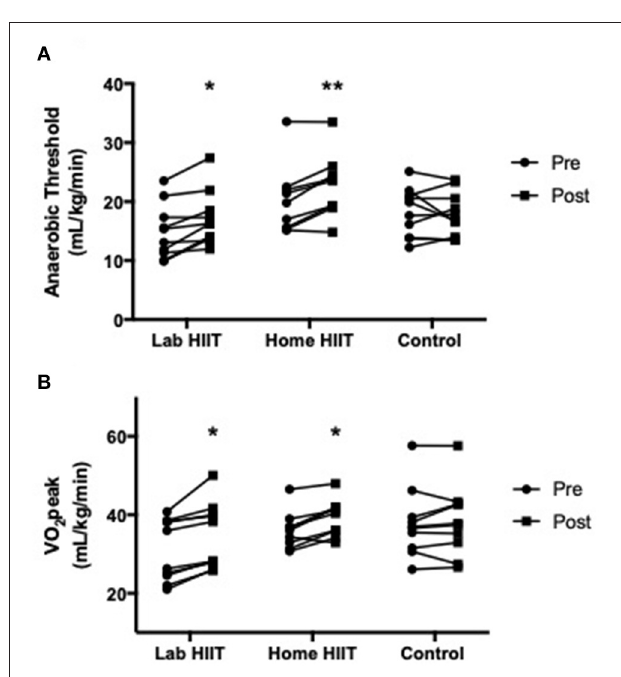
TX, USA). The level of significance was set at p < 0.05.